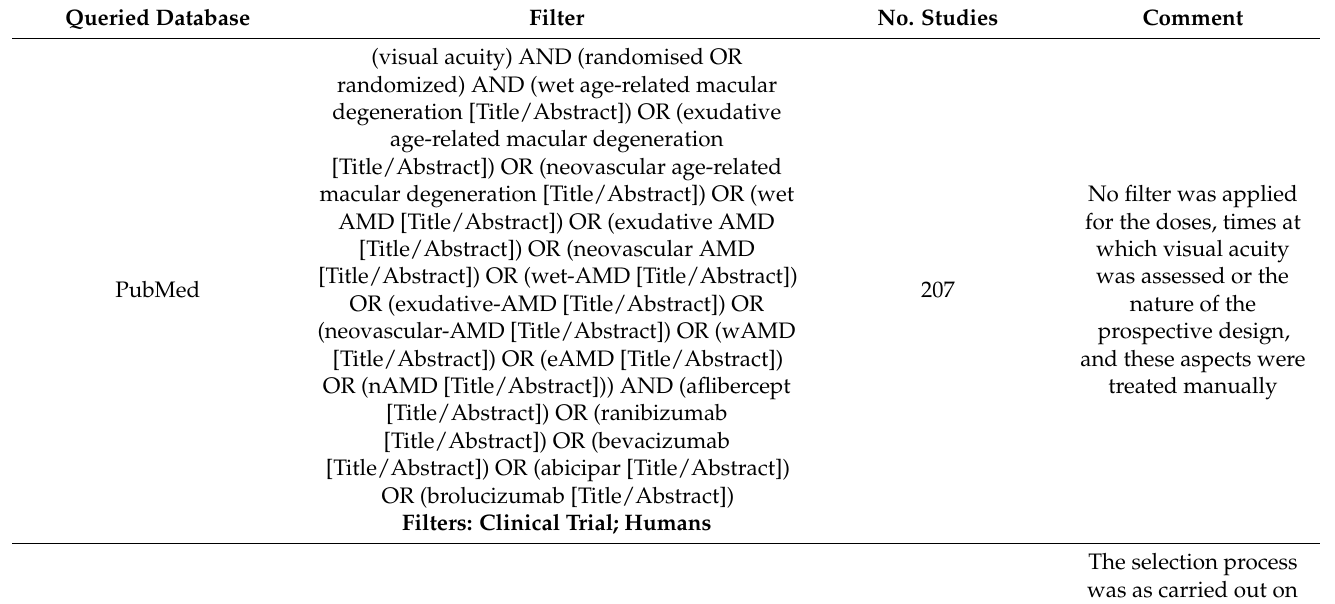
Table 1. Search terms used in the systematic literature